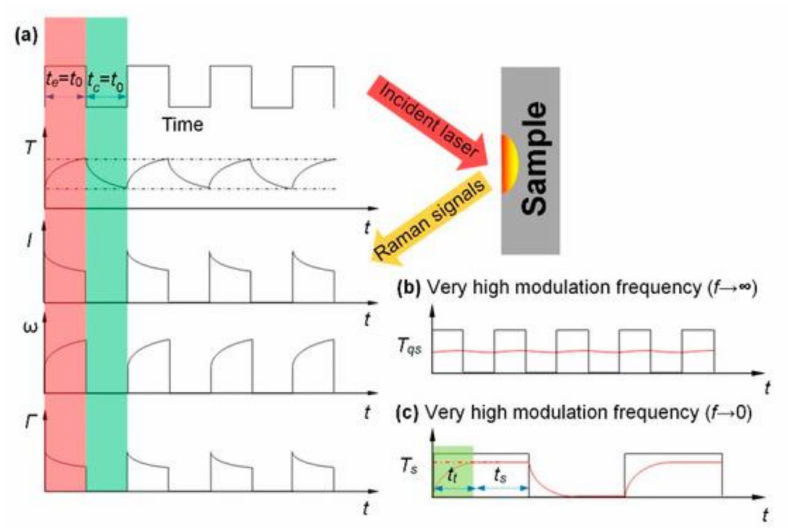
Figure 7. Concept of FR-Raman. ( a ) Time profiles of laser pulse, temperature evolution ( T ), Raman peak intensity ( I ), peak shift ( ω ) and linewidth ( Γ ). ( b ) Temperature variation ( T QS ) at quasi-steady state. ( c ) Temperature variation ( T S ) at very low frequency. Reprinted with permission from [49] © The Optical Society. Copyright 2016, The Optical